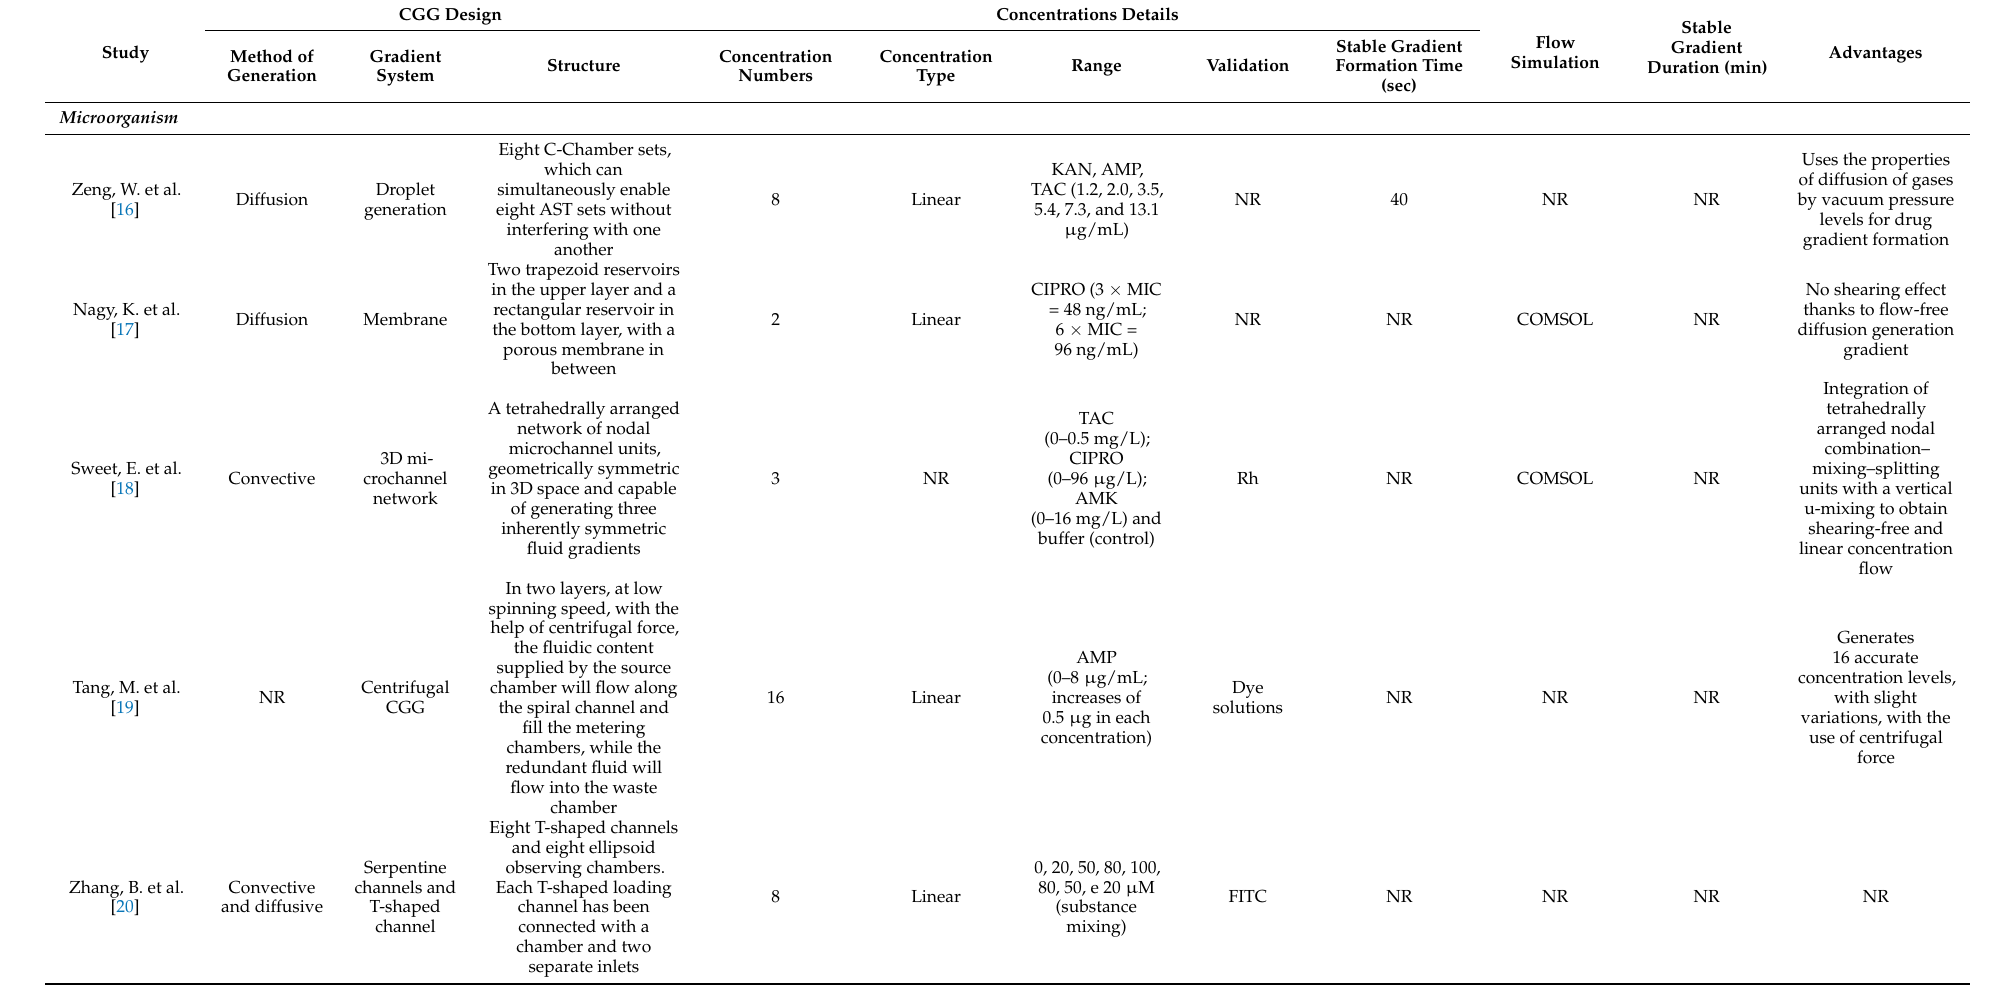
Table 2. Concentration gradient generator characteristics of microfluidic